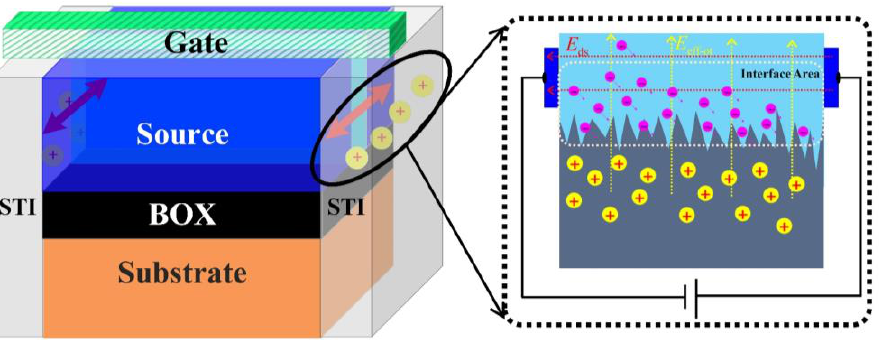
Figure 9. Schematic illustration of the physical mechanism of radiation-induced carrier scattering rate increases in the delay transistor N5 of the 7T